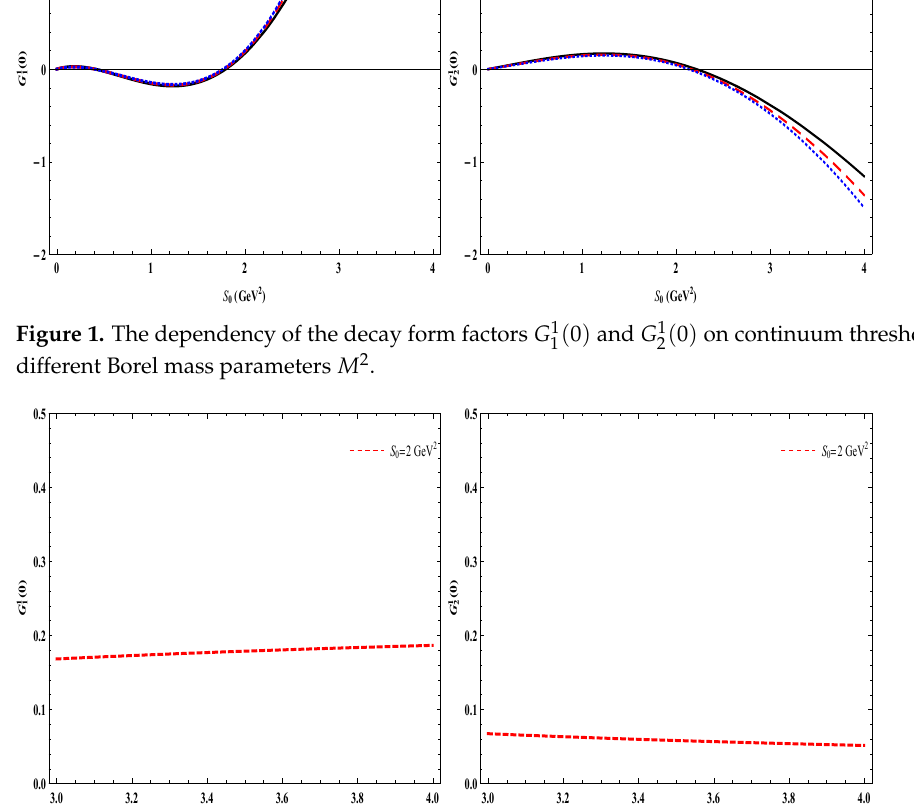
Figure 2. The dependency of the decay form factors G 1 M 2 at fixed continuum threshold S 0